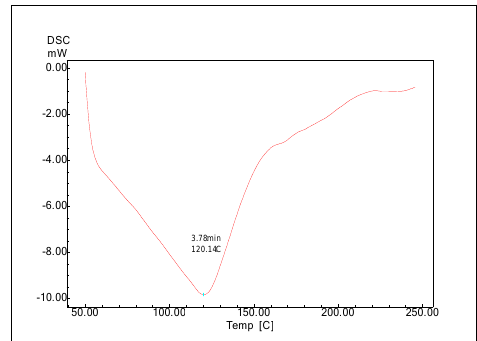
Figure 7: DSC curve of PVP.